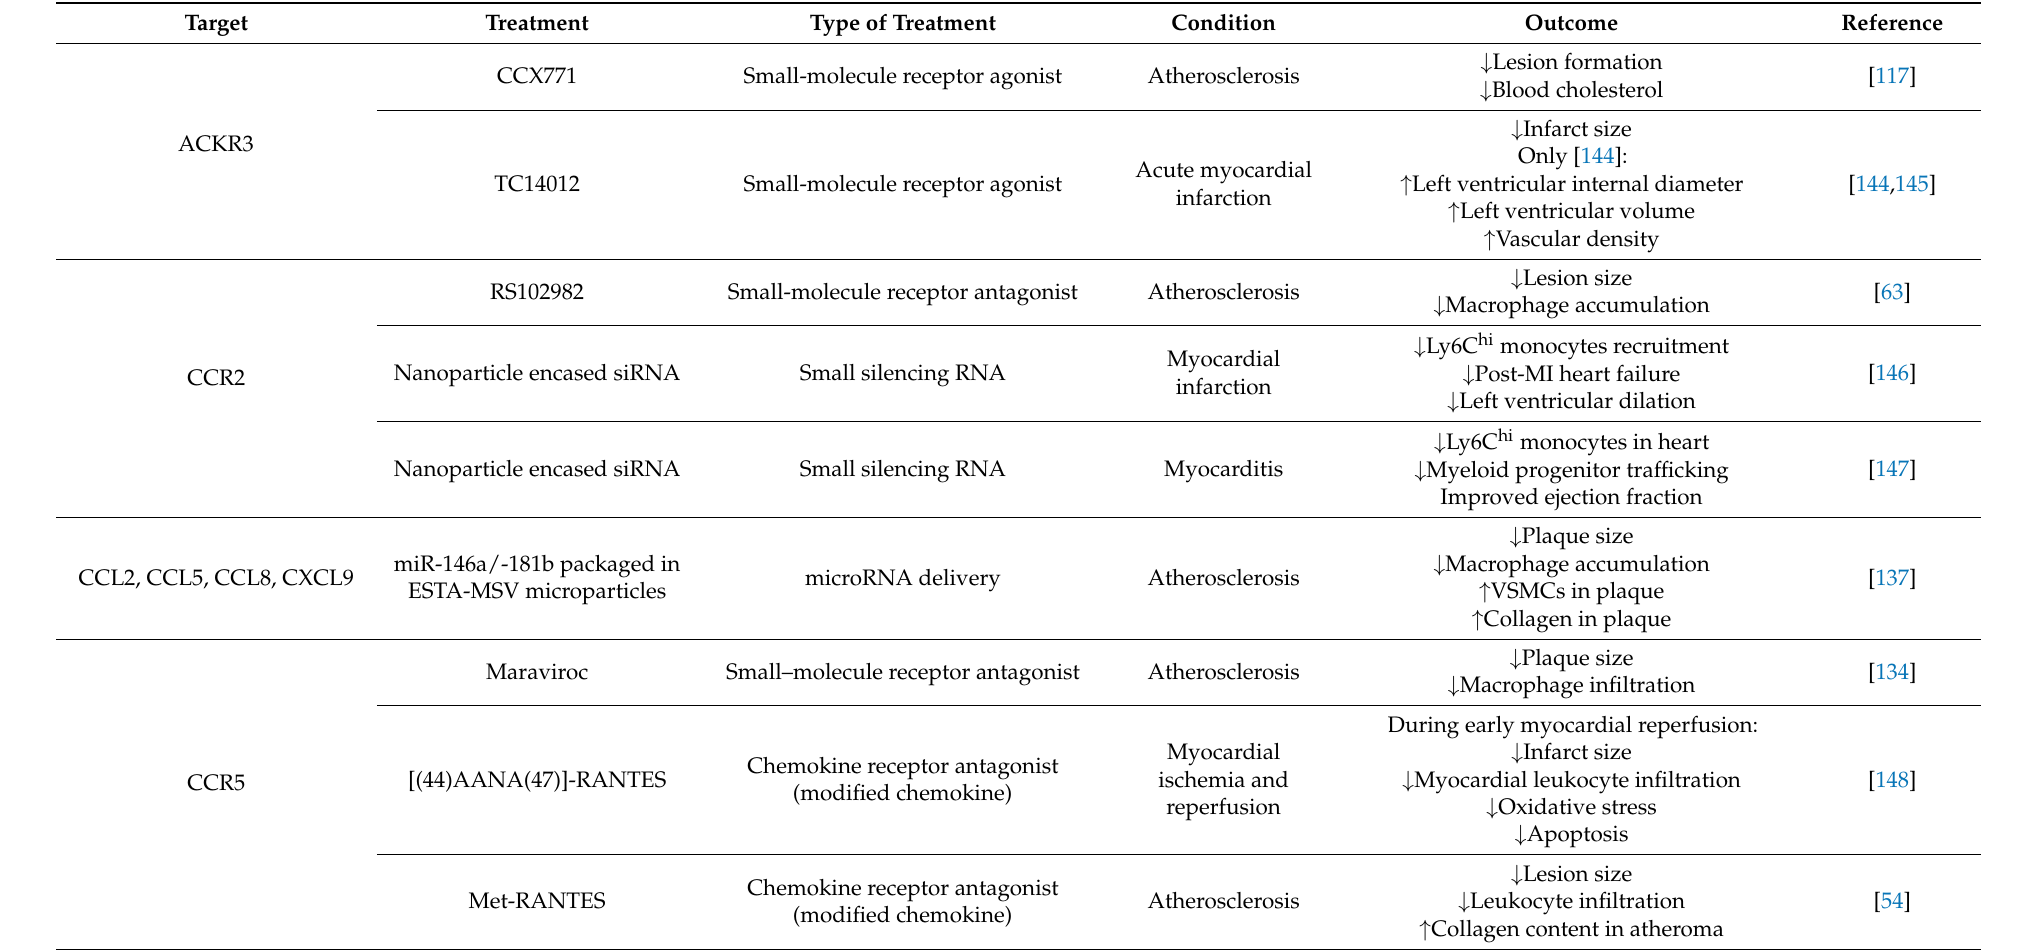
Table 1. Preclinical studies targeting chemokines and chemokines receptors in